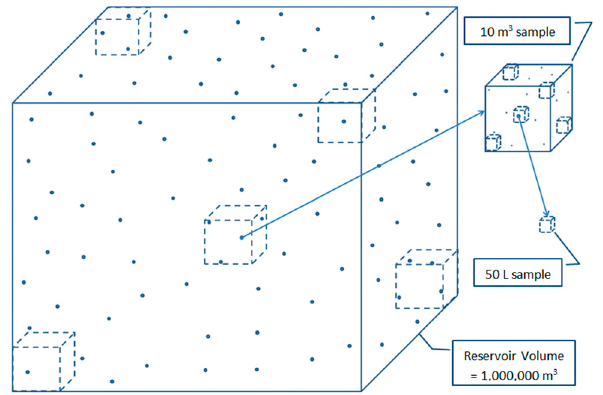
Figure 3. Schematic illustration of the Poisson distribution of Cryptosporidium oocysts and Giardia cysts in surface water where ambient concentrations are near the analytical method limit of